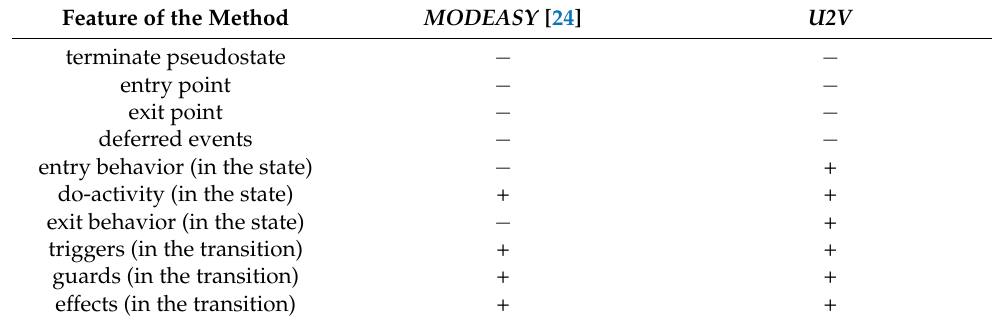
Table 2. Cont. Feature of the Method MODEASY [24] U2V terminate pseudostate − − entry point − − exit point − − deferred events − − entry behavior (in the state) − + do-activity (in the state) + + exit behavior (in the state) − + triggers (in the transition) + + guards (in the transition) + + effects (in the transition) +